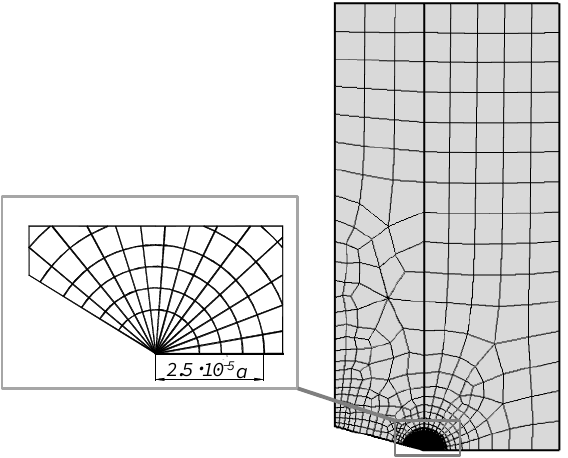
Figure 5. A typical finite element mesh used for modelling the specimens.